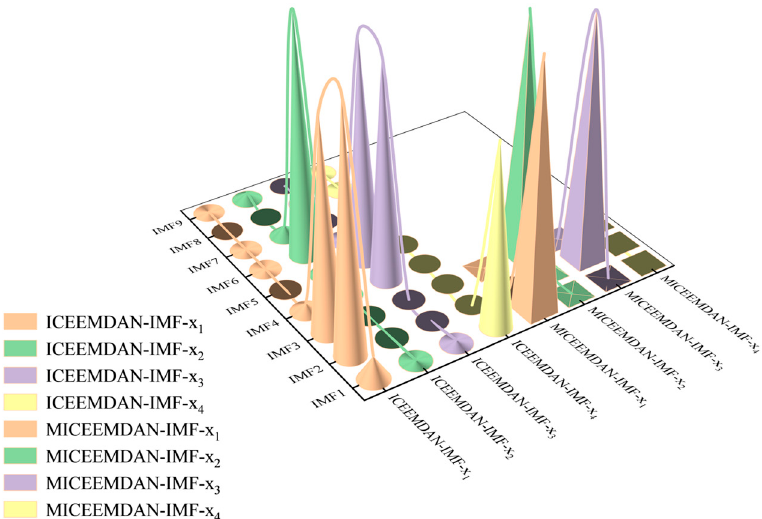
Figure 6. Correlation coefficients of the original simulation signal decomposition results of the two